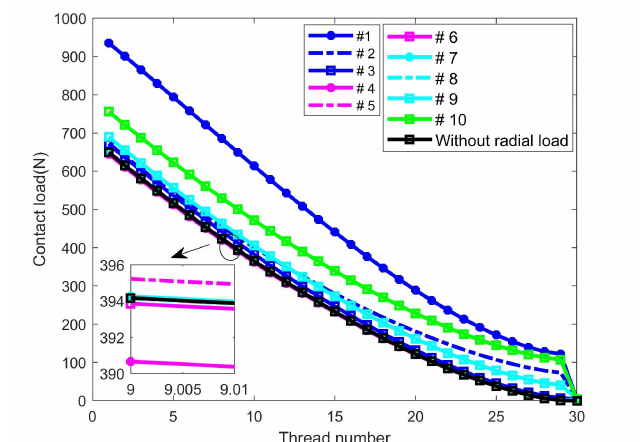
Figure 13. Contact load distribution in different threads of the robot system of case 2.